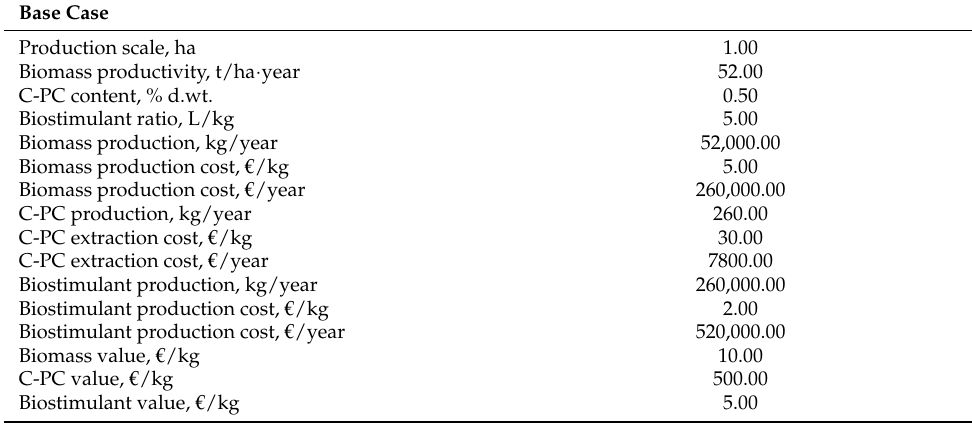
Table 3. Values for the base case study of a 1-ha facility producing Oscillatoria sp. biomass in open reactors for the production of biomass, C-PC extracts, and/or